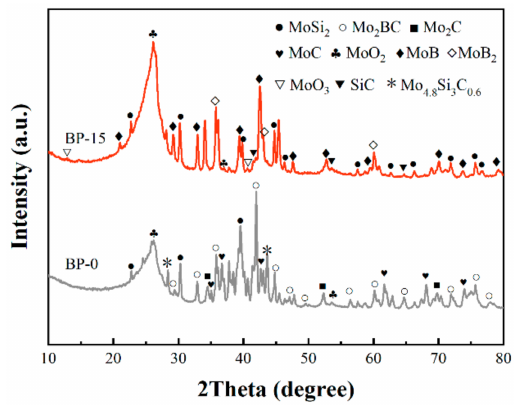
Figure 13. XRD patterns of residues from the ablated surface for BP-0 and